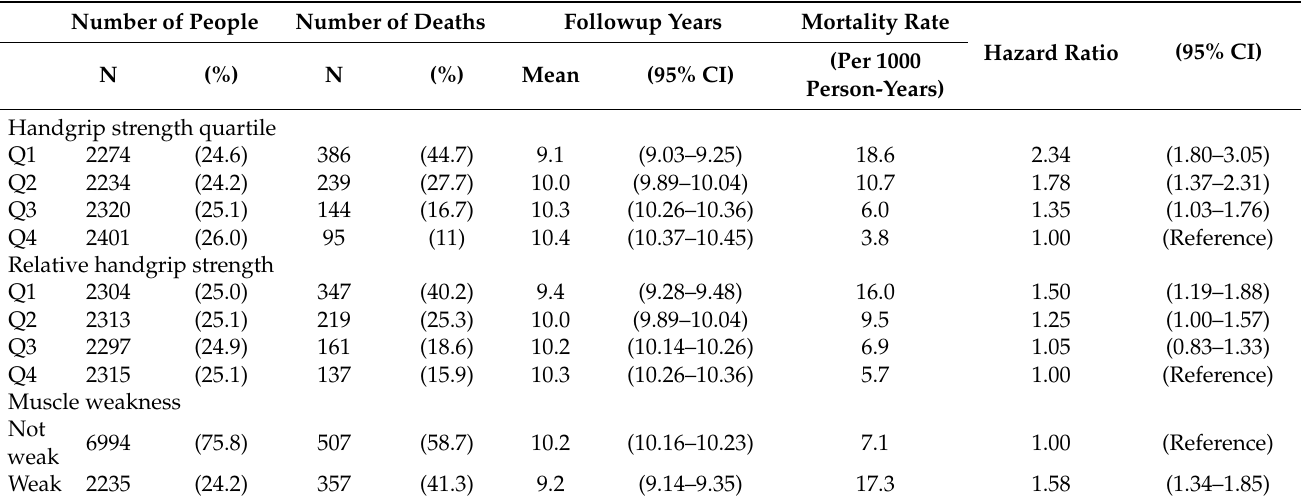
Table 4. Results for the associations of the handgrip strength and weakness group on time to premature mortality.